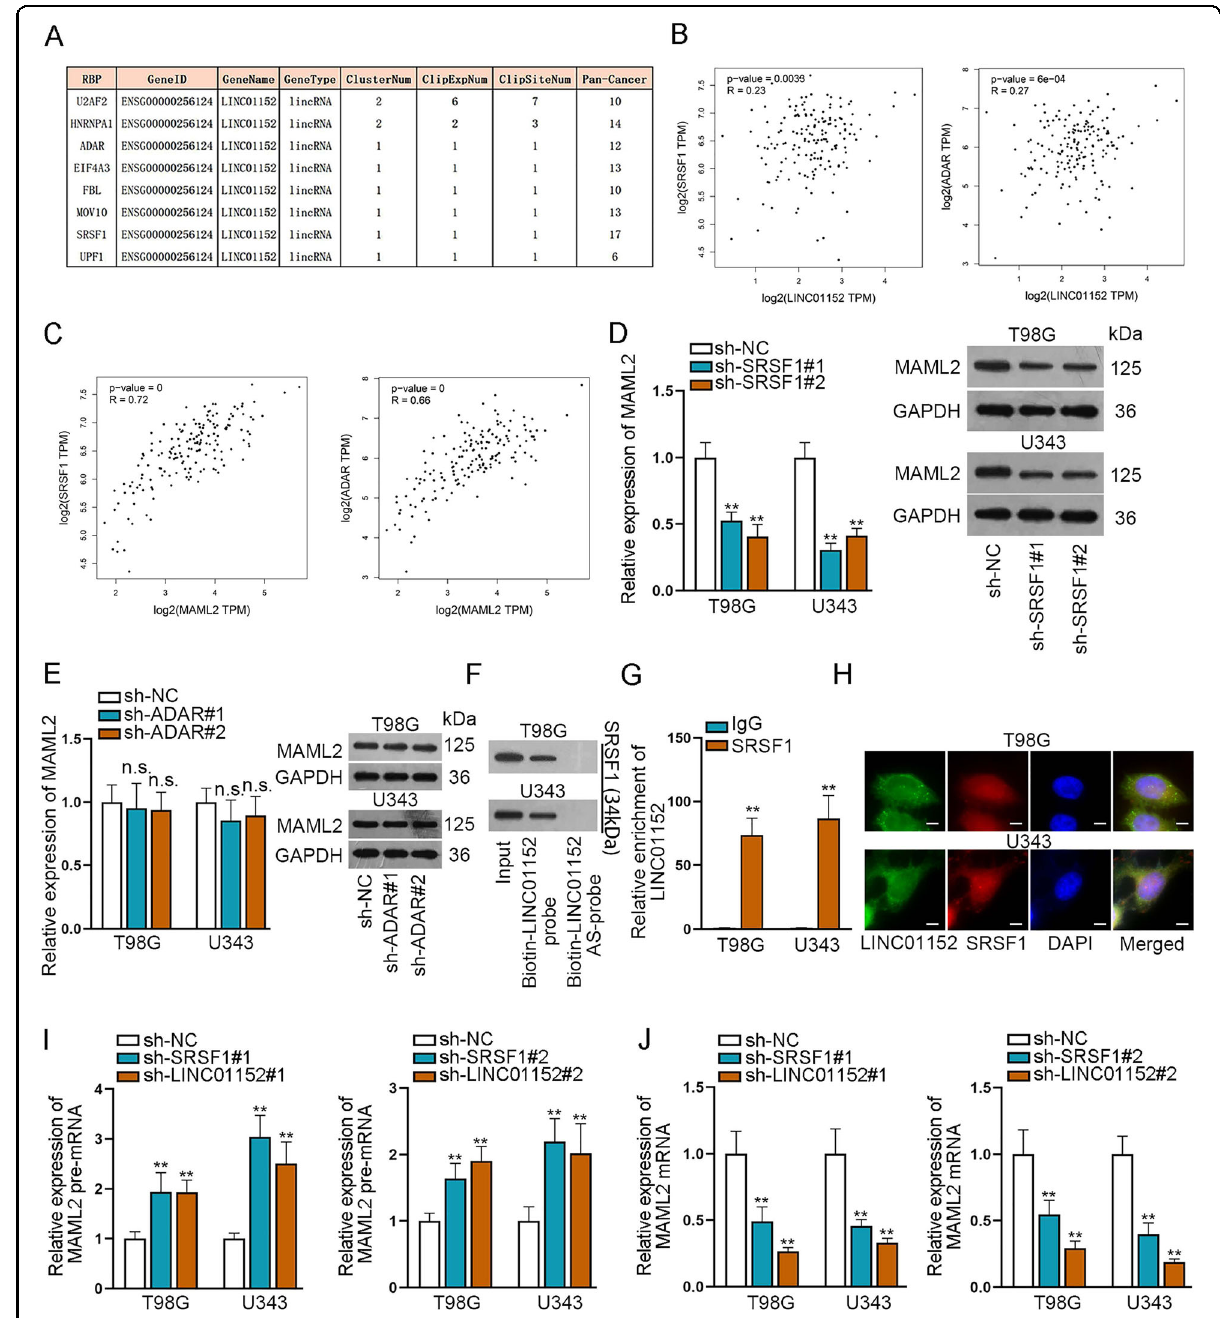
Fig. 5 LINC01152 interacted with SRSF1 to boost MAML2 expression in GBM cells. A Potential RNA binding proteins were searched via ENCORI database. B , C Correlation analysis in GEPIA database was implemented to search the correlation of LINC01152 and MAML2 with SRSF1 and ADAR. D , E Expression of MAML2 was assessed via qRT-PCR and western blot in T98G and U343 cells when SRSF1 or ADAR was inhibited. F , G RNA-protein pull down assay and RIP assay searched the binding between LINC01152 and SRSF1. H FISH assay (scale bar = 15 μ m) identi fi ed the co-location of LINC01152 and SRSF1 in T98G and U343 cells. I , J Expression of MAML2 pre-mRNA and MAML2 mRNA was detected via qRT-PCR in T98G and U343 cells when SRSF1 or LINC01152 was silenced. ** P < 0.01, n.s.: no signi fi